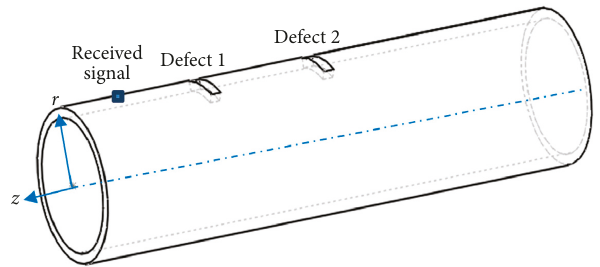
Figure 8: Schematic diagram of the double-defect pipeline